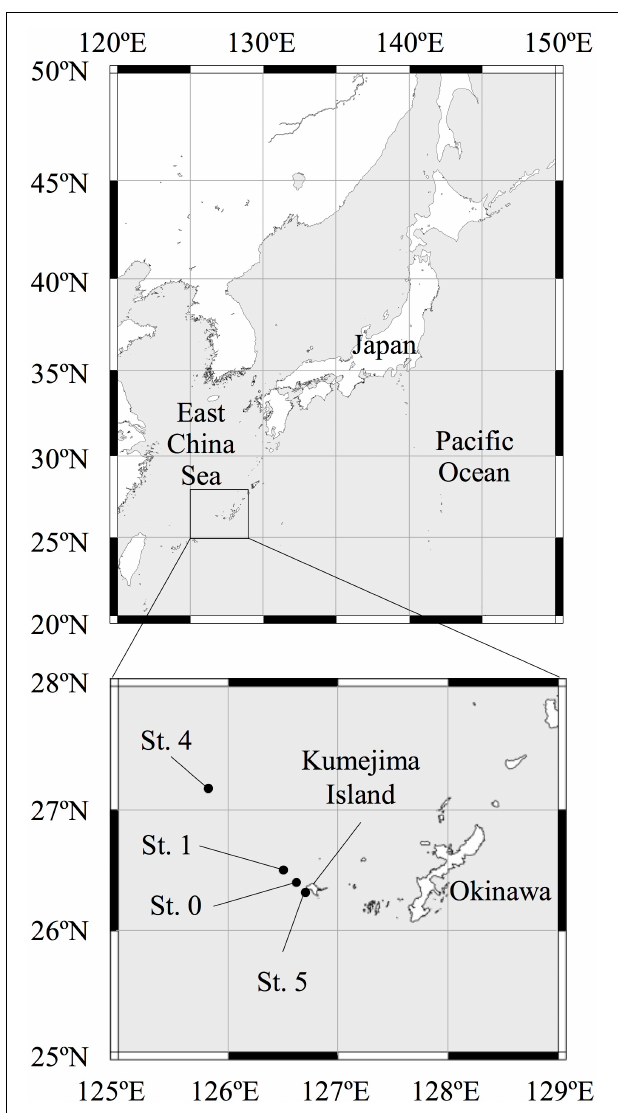
FIGURE 1 | Map of the sampling stations in the East China Sea.